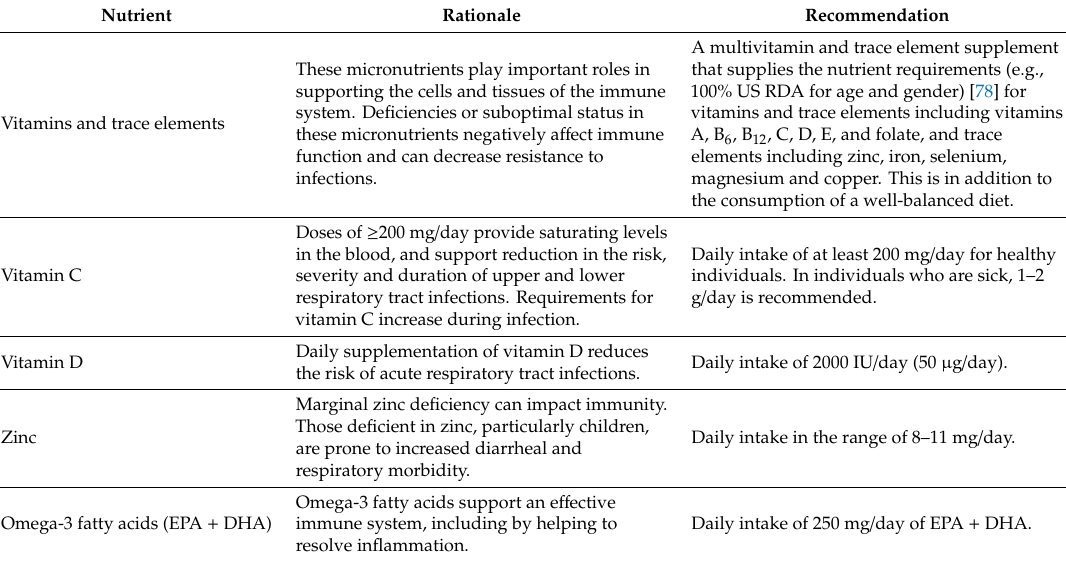
Table 1. Recommended intakes of selected nutrients to support optimal immune